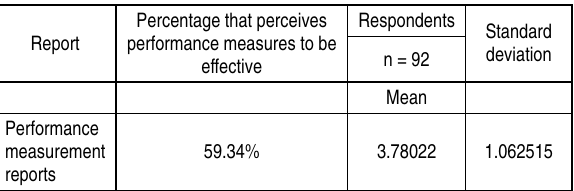
Table 4. Perceived effectiveness of